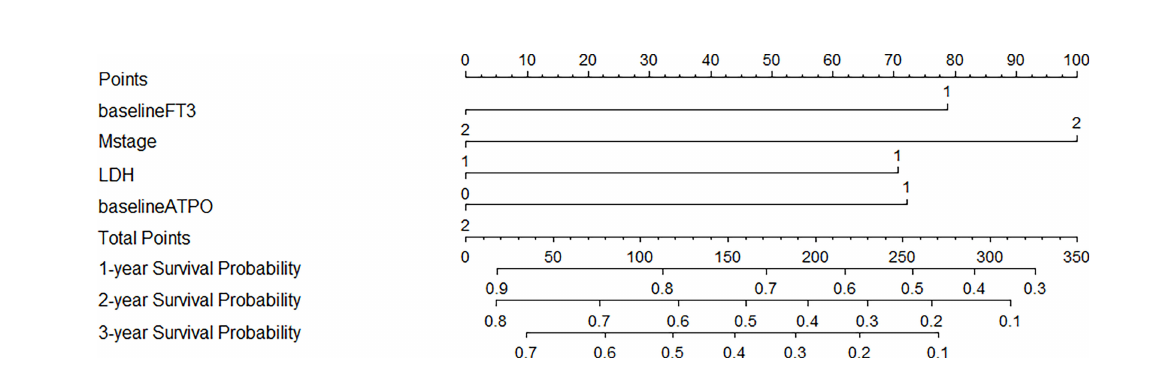
FIGURE 2 Prognostic Nomograms of 1-, 2-, and 3-year OS for patients with metastatic melanoma. For every patient in the nomogram, four lines are drawn upward to calculate the points received from the four predictors. The sum of the points is located on the “ Total Points ” axis. In addition, the possibility of 1-, 2-, and 3-year OS is determined by drawing a downward